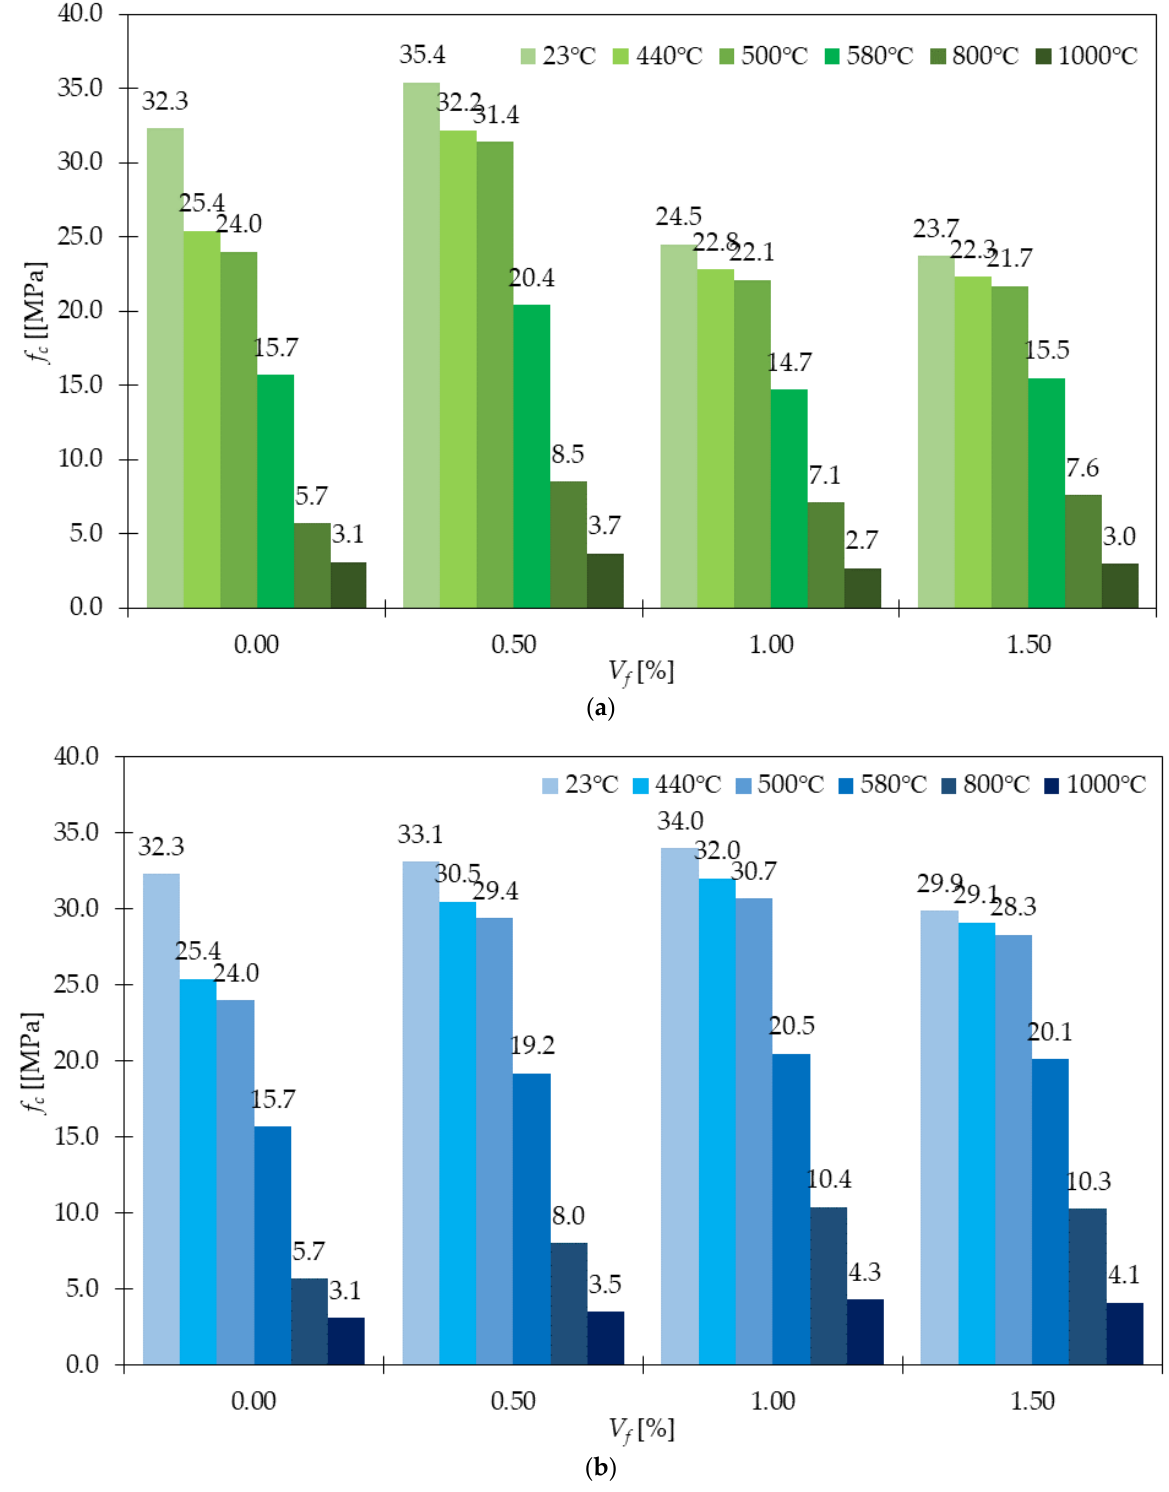
Figure 20. Effect of high temperature on f c of PC and GFRC for GF with different lengths: ( a ) l f = 6 mm; ( b ) l f = 25.4 mm [29].